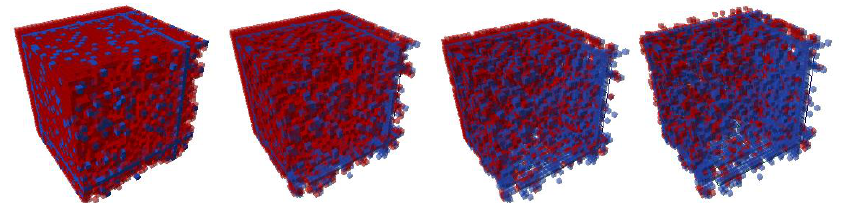
Figure 10. Extraction of aniline from the porous catalyst calculated using CA approach.